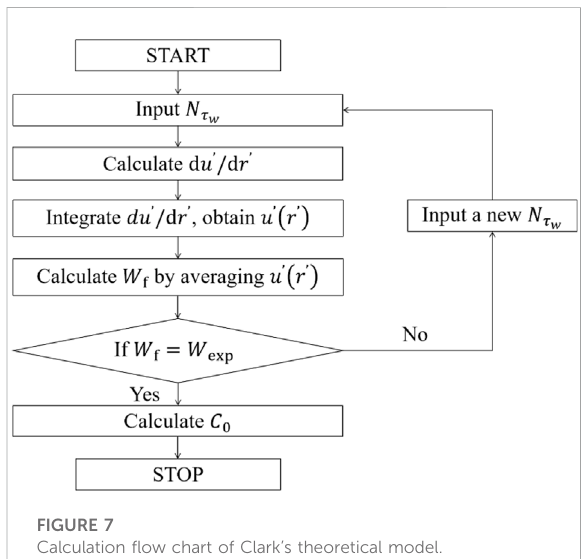
FIGURE 8 Calculated velocity along radial